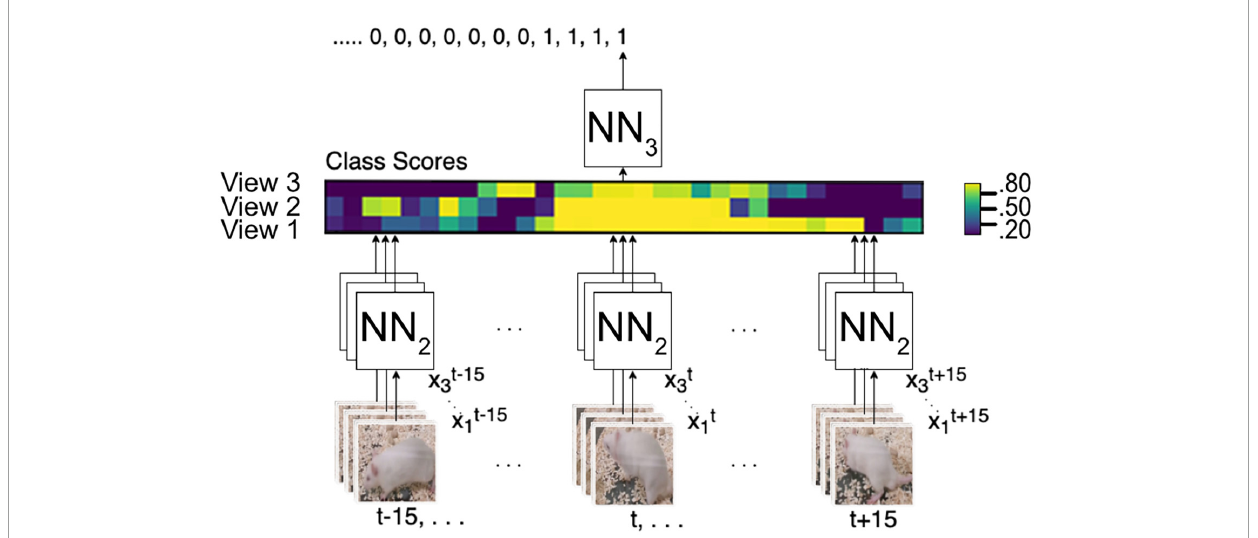
FIGURE5 Multi-view integration and time series analysis framework. NN2 analyses all frames from t–15 to t15 from all camera angles to create a vector map from class scores. NN3 generates the final prediction from the vector map.